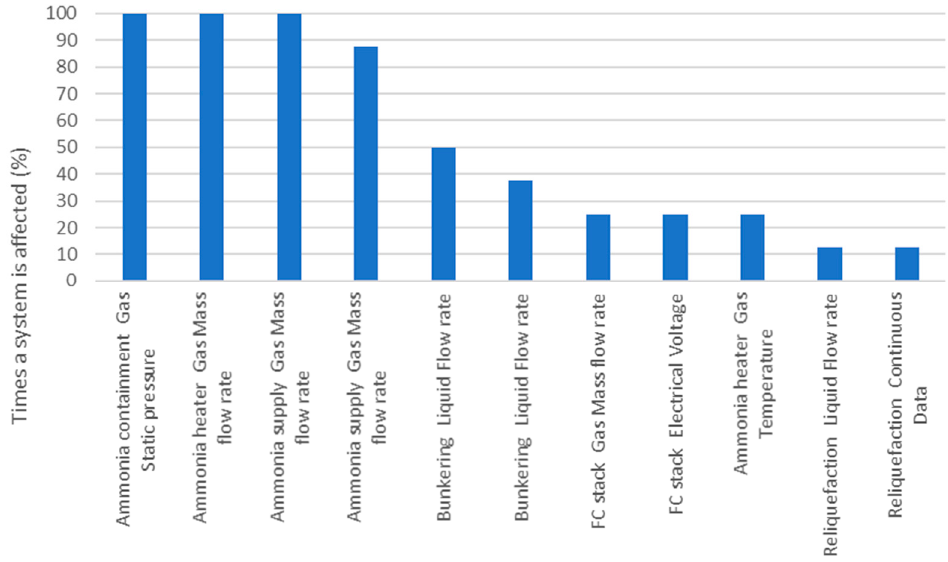
Figure 7. Functions and flows of a fuel-cell module.